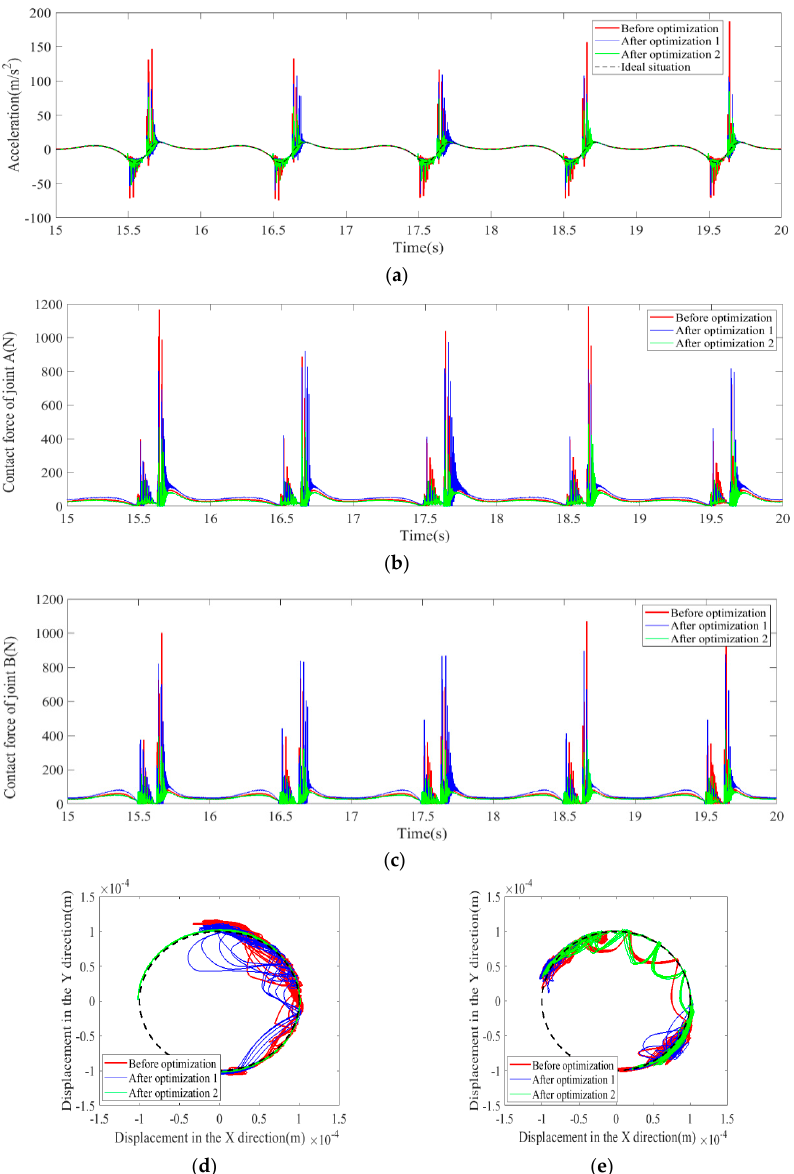
Figure 5. Comparative analysis of dynamics response before and after optimization. ( a ) Acceleration. ( b ) Contact force of joint A. ( c ) Contact force of joint B. ( d ) central trajectory of clearance A. ( e ) central trajectory of clearance B.